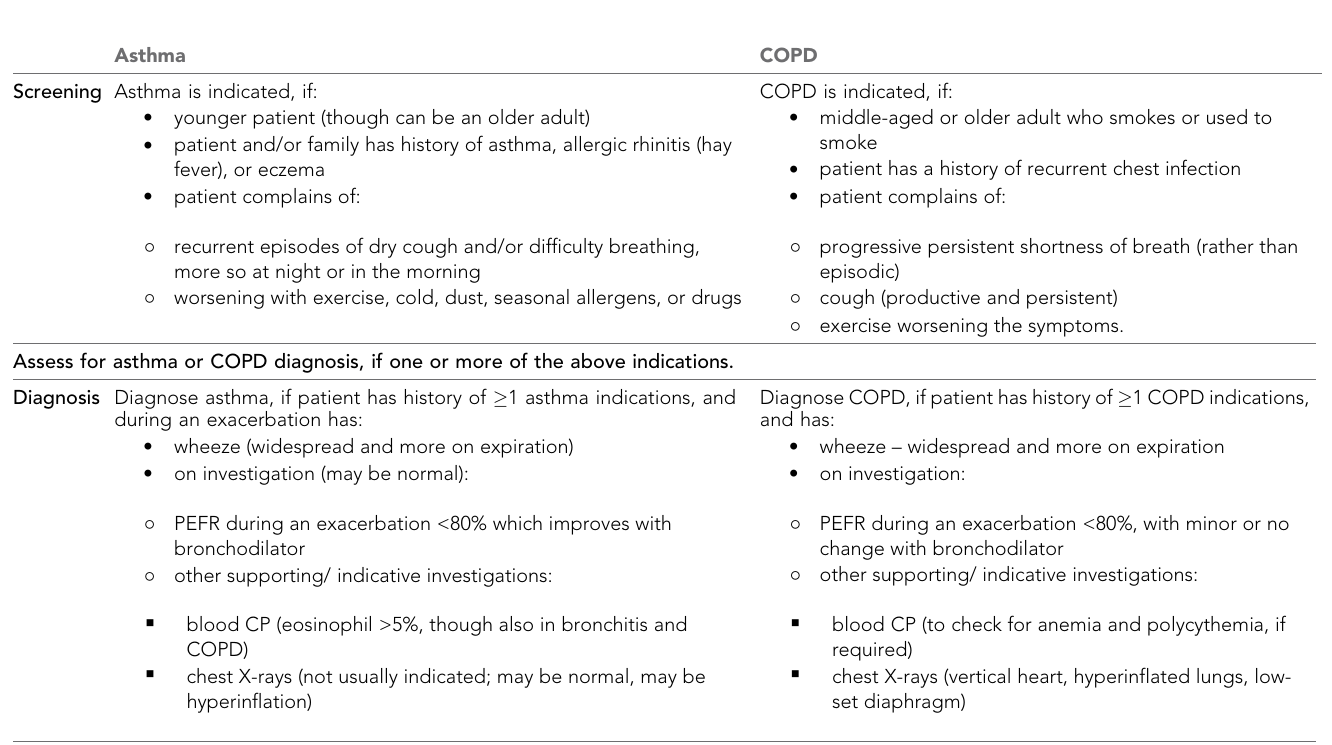
Box 4. An outline of screening and diagnosis protocols for asthma and COPD (extracted from case management desk-guide)